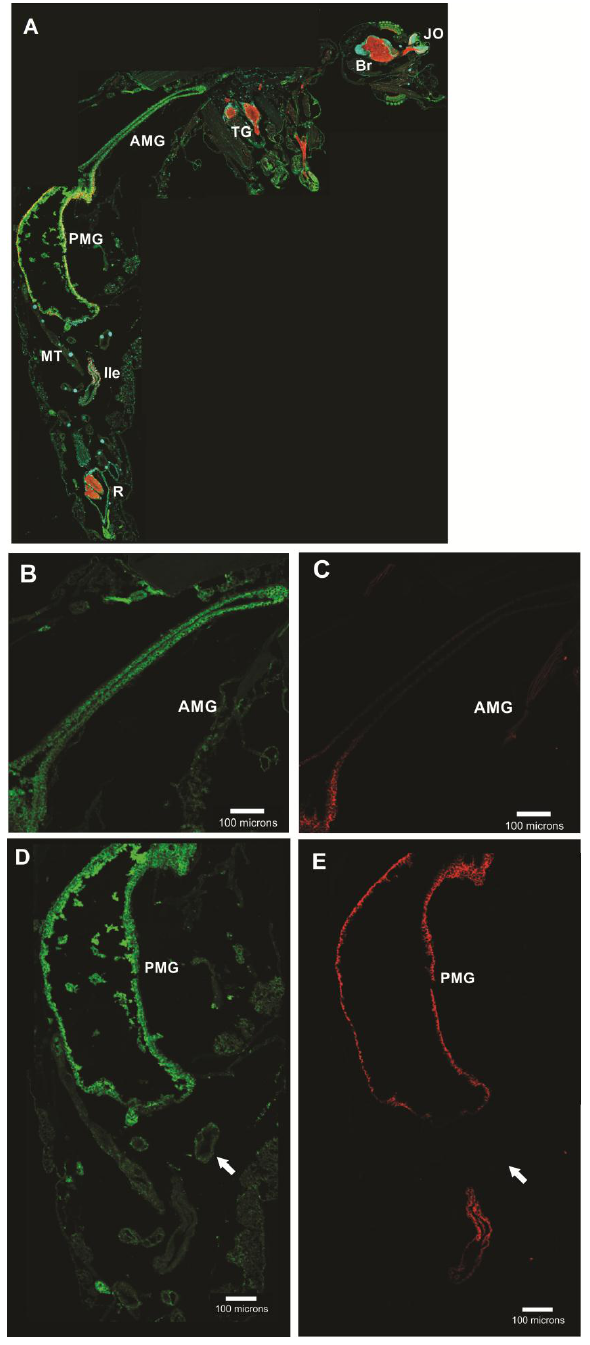
Figure 9. AeCA9 is compartmentalized to the female PMG and MTs. This figure shows transverse sections of a female adult. These sections were immunostained with antibodies targeting the following: AeCA9 (green), NaK-ATPase (red), and DAPI (cyan). ( A ) In the montage, the following organs can be seen: Johnston (cid:48) s organ (JO), Brain (Br), thoracic ganglia (TG), anterior midgut (AMG), posterior midgut (PMG), Malpighian tubules (MT), ileum (Ile), and rectum (R); ( B ) AeCA9 is detectable in the cytoplasm throughout the length of the AMG; ( C ) NaK-ATPase is minimally expressed throughout the length of the AMG; ( D ) AeCA9 is detected in the PMG, while a faint signal for AeCA9 is detected in the MTs (arrow); ( E ) NaK-ATPase is detected on the basal membranes of the PMG epithelial cells and the ileum. The scale bars in A – E represent 100